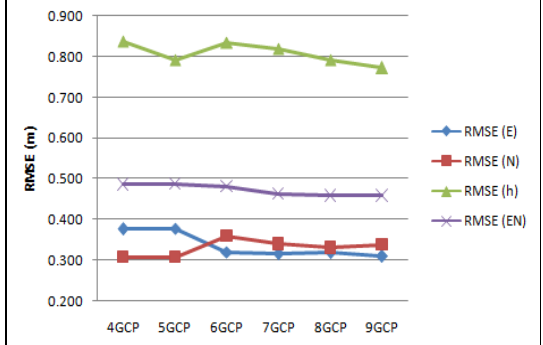
Figure 5. Line Graph for RMSE Value based on Different Number of GCPs.